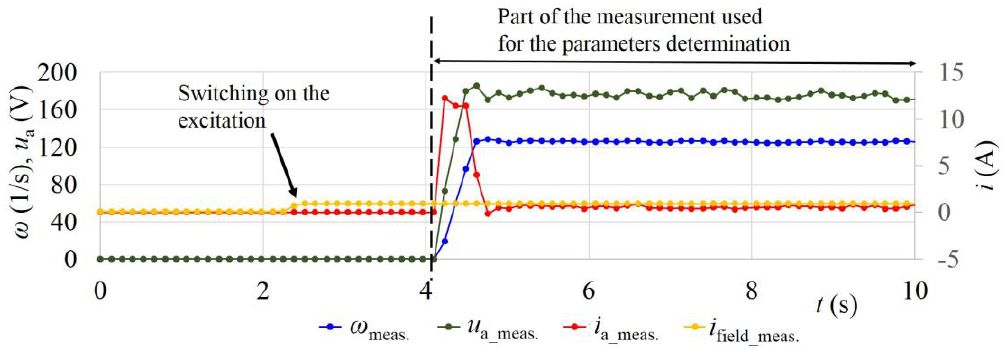
Figure 6. Preparation of the measured data.